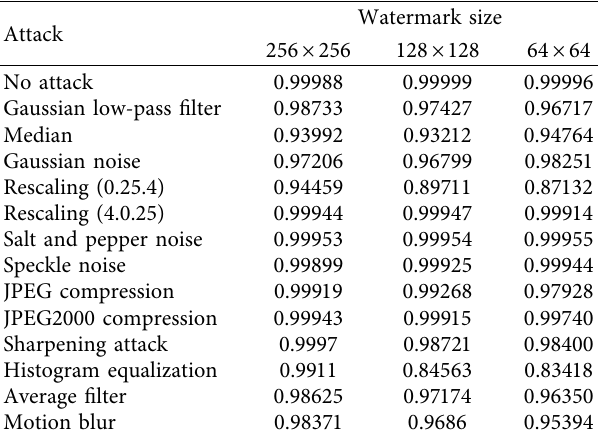
Table 5: The robustness performance of the watermarked cancer cell line image obtained using different-sized